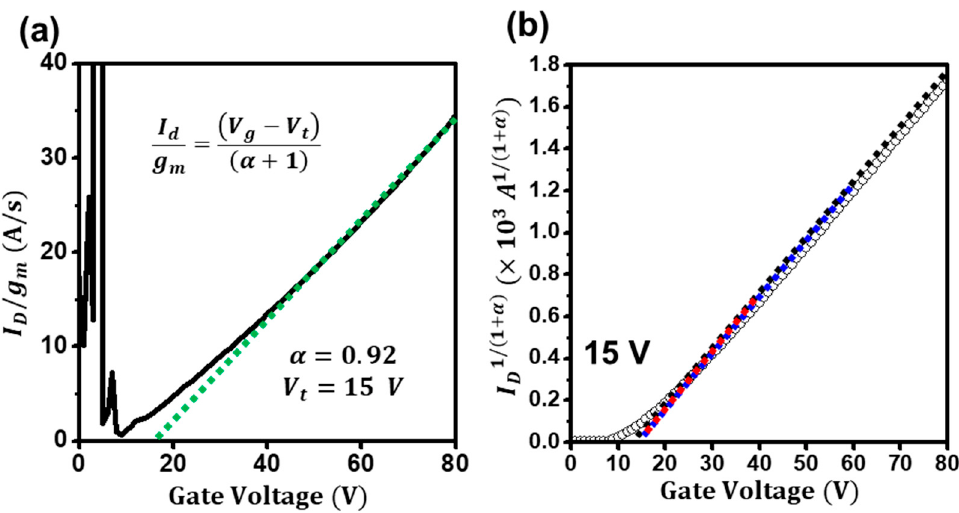
Figure 2. ( a ) The modified plot of I d /g m for the ZnO TFTs. ( b ) The power-law-term-removed threshold-voltage extraction of the ZnO TFTs.